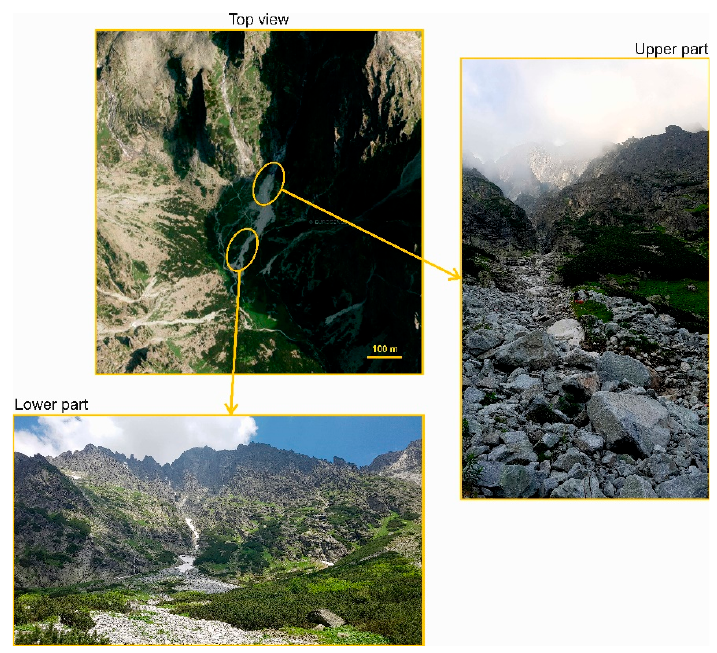
Figure 3. Debris cone—upper part and lower part.